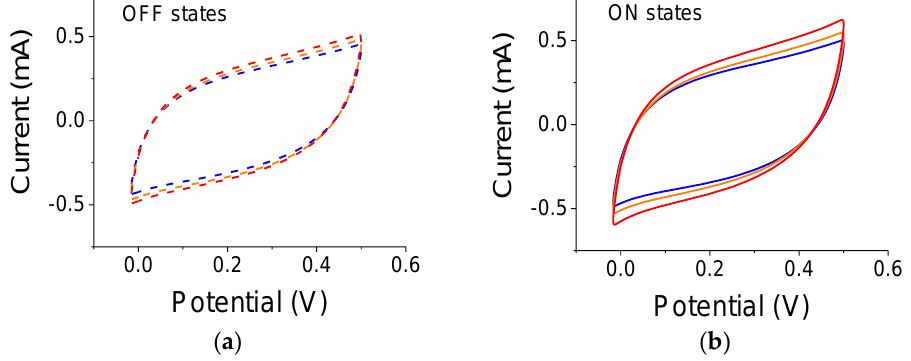
Figure 6. ( a ) Light OFF, C-V reference curves for 2 µm particles measured before illumination with a 75 W white-light source. Experiments were carried out after the conclusions of the experiments with the 300 W lamp. The colored dashed curves correspond to successive references for data taken with the blue, yellow, and no filter, respectively. ( b ) C-V curves for light ON cases; the blue, yellow, and red curves correspond to illumination with blue, yellow, and no filter, respectively. Scan rate